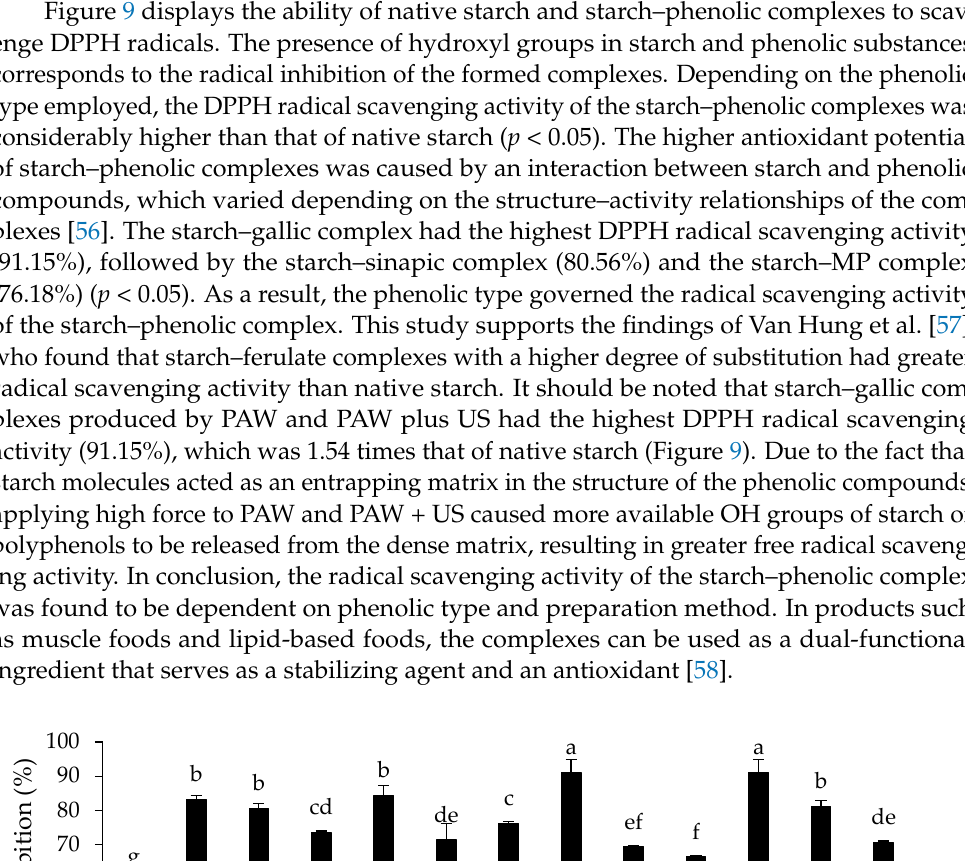
18 of 21 Figure 8. Water solubility index ( a ) and swelling power ( b ) of rice starch – phenolic complexes at different temperatures. Different phenolic compounds — gallic acid (G), sinapic acid (S), and crude